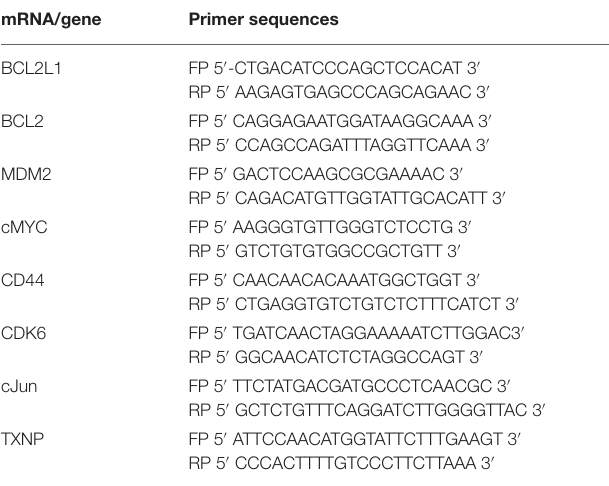
TABLE 2 | Primers used to detect mRNAs hnRNPA2B1-RIP lysates using qPCR analysis following exposure to extract of Cotyledon orbiculata . mRNA/gene Primer